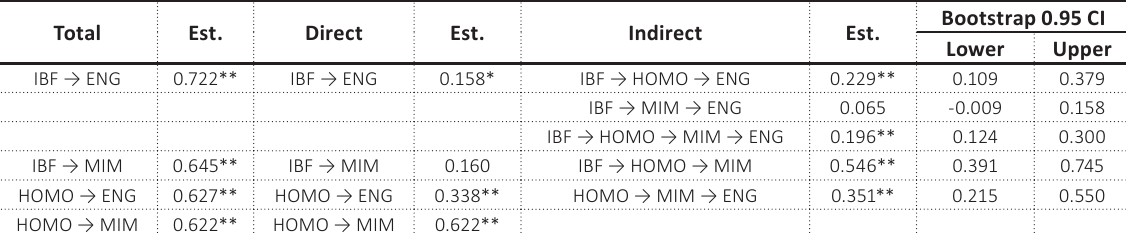
Table 3. Total, direct, and indirect